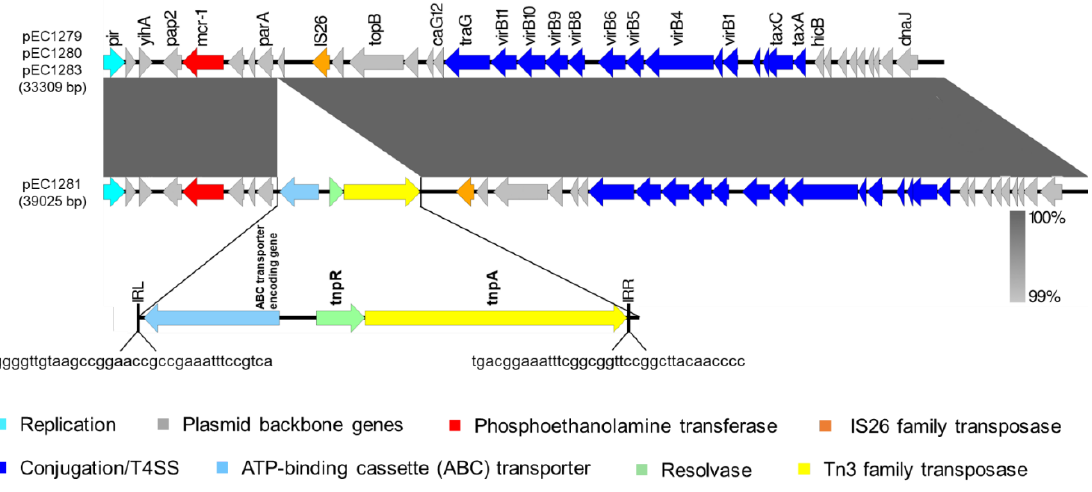
Figure 4. Linear comparison of the pEC1279-like plasmids (pEC1279, pEC1280, and pEC1283) and pEC1281, which contained a Tn3 family transposon. IRL—left-inverted repeated sequence; IRR—right-inverted repeated.